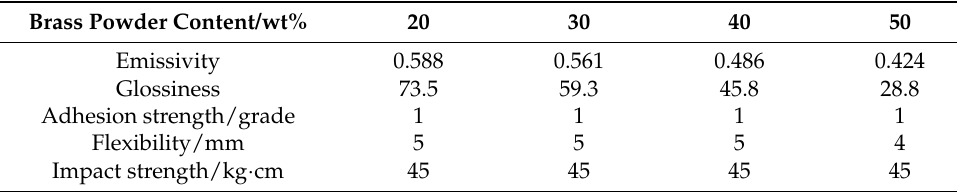
Table 2. Performance index of coatings with different contents of brass